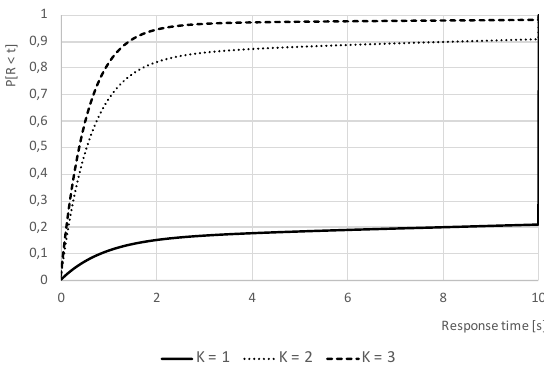
Figure 4. Distributions of response time with Timeout=10 s and λ = 0.9 r/s for a variable number K of